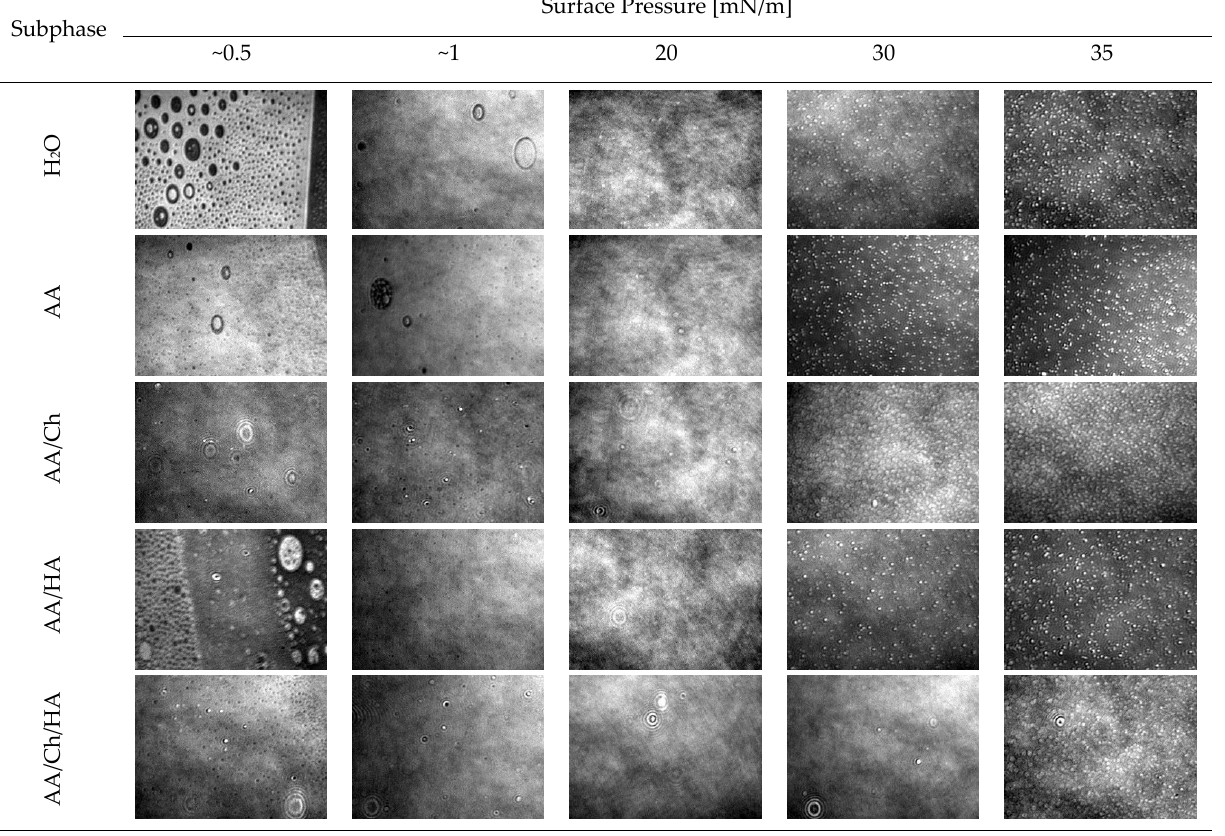
Figure 6. Structure of the S. aureus lipid monolayer during their compression (at surface pressures of 0.5, 1, 20, 30 and 35 mN/m) on the different subphases (AA–acetic acid, AA/Ch–chitosan on acetic 0.5, 1, 20, 30 and 35 mN/m) on the different subphases (AA—acetic acid, AA/Ch—chitosan on acetic acid, AA/HA–hyaluronic acid in acetic acid, AA/Ch/HA–chitosan in acetic acid with the addition of acid, AA/HA—hyaluronic acid in acetic acid, AA/Ch/HA—chitosan in acetic acid with the addition hyaluronic acid). of hyaluronic